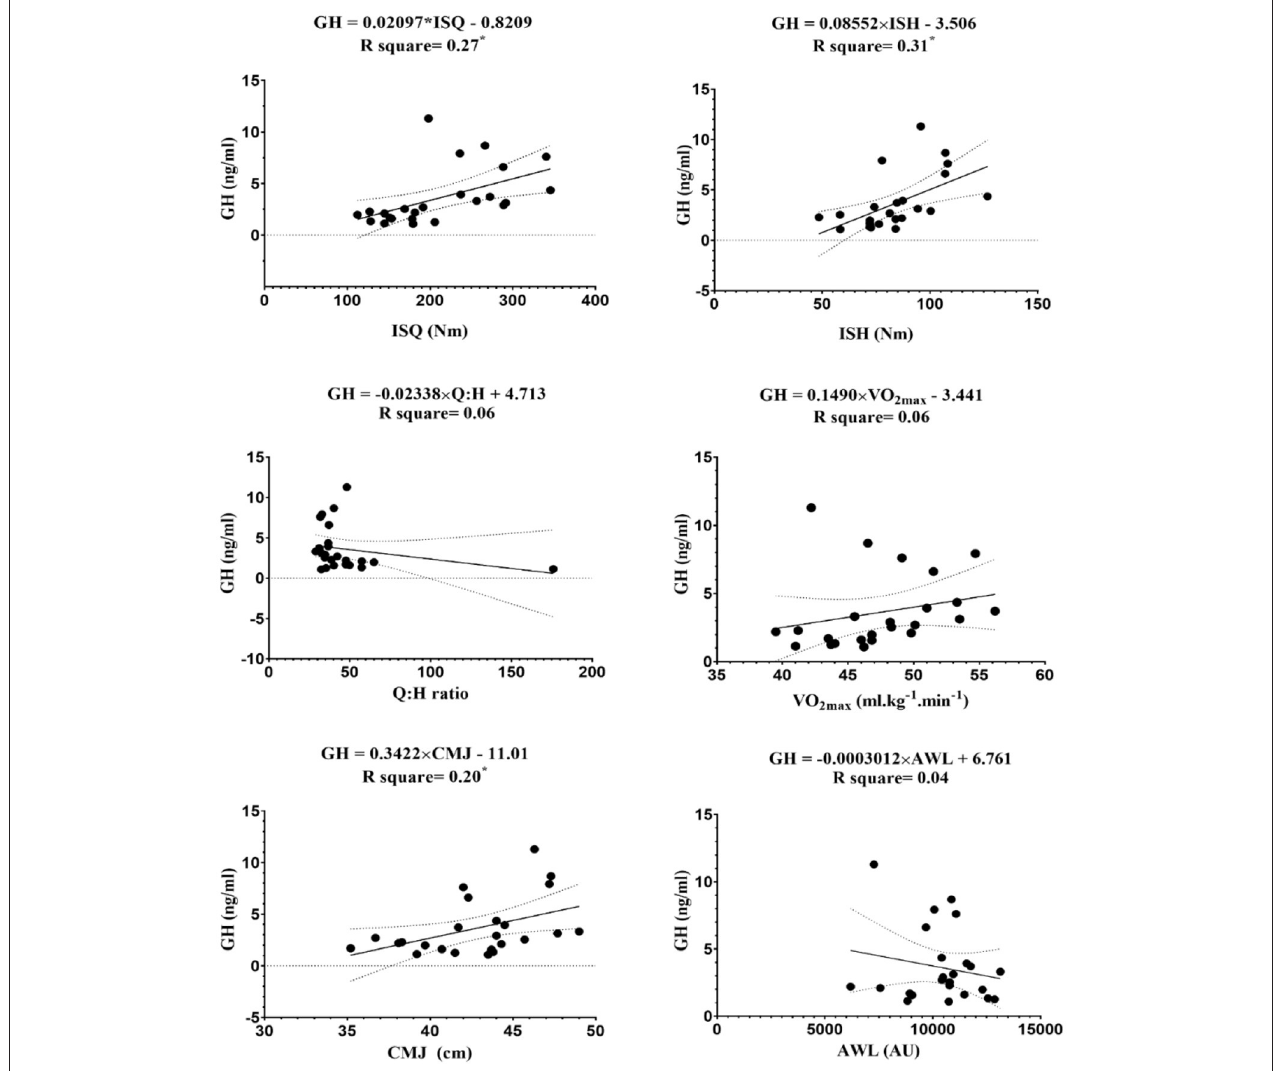
FIGURE 4 | Regression analysis to explain fitness levels and accumulated workload training (AWL) (the average of the three stages) with GH, growth hormone; ISH, isometric muscular strength of the hamstring muscles; ISQ, isometric muscular strength of the quadriceps muscles; H:Q, the strength of isometric quadriceps to hamstring ratio; VO 2max , maximal oxygen uptake; CMJ, countermovement jump; AWL, accumulated workload training; Nm, Newton meter; AU, arbitrary unit. * Significant differences p ≤